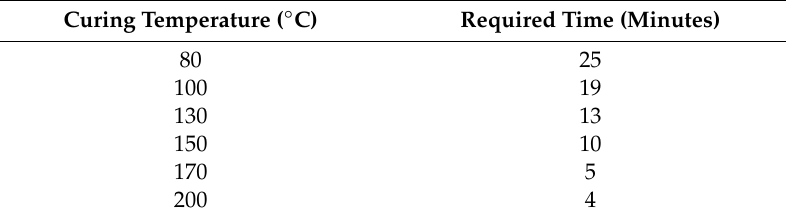
Table 1. Curing temperature–time relation.